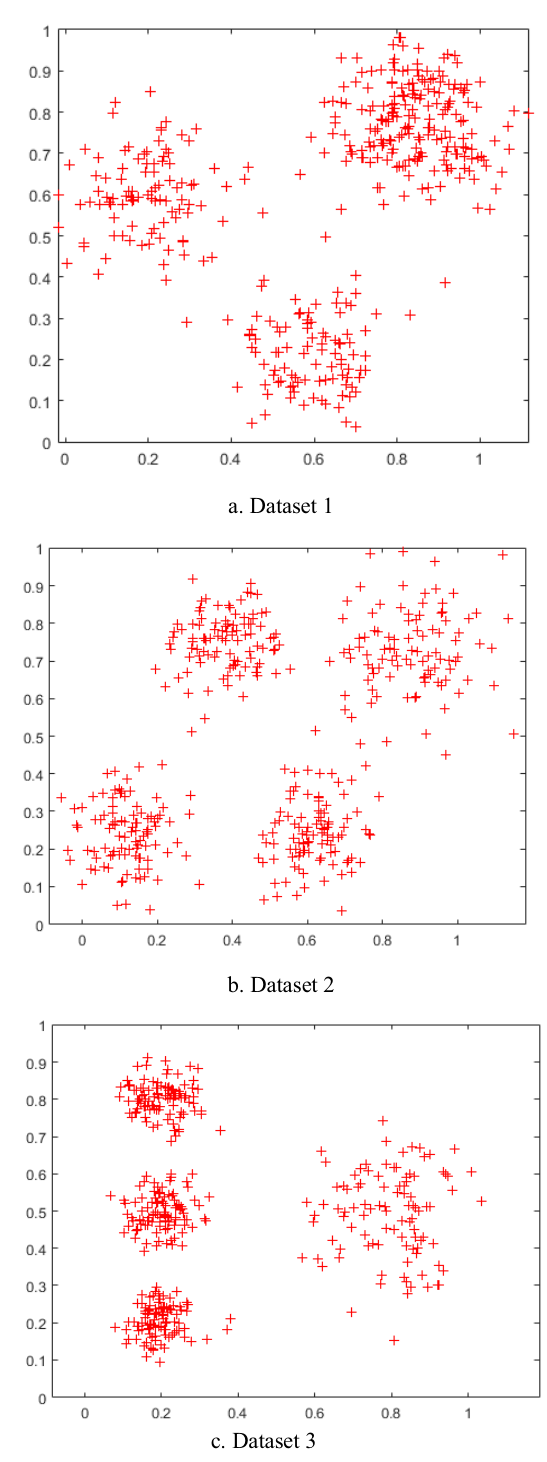
Fig. 4. Random dataset